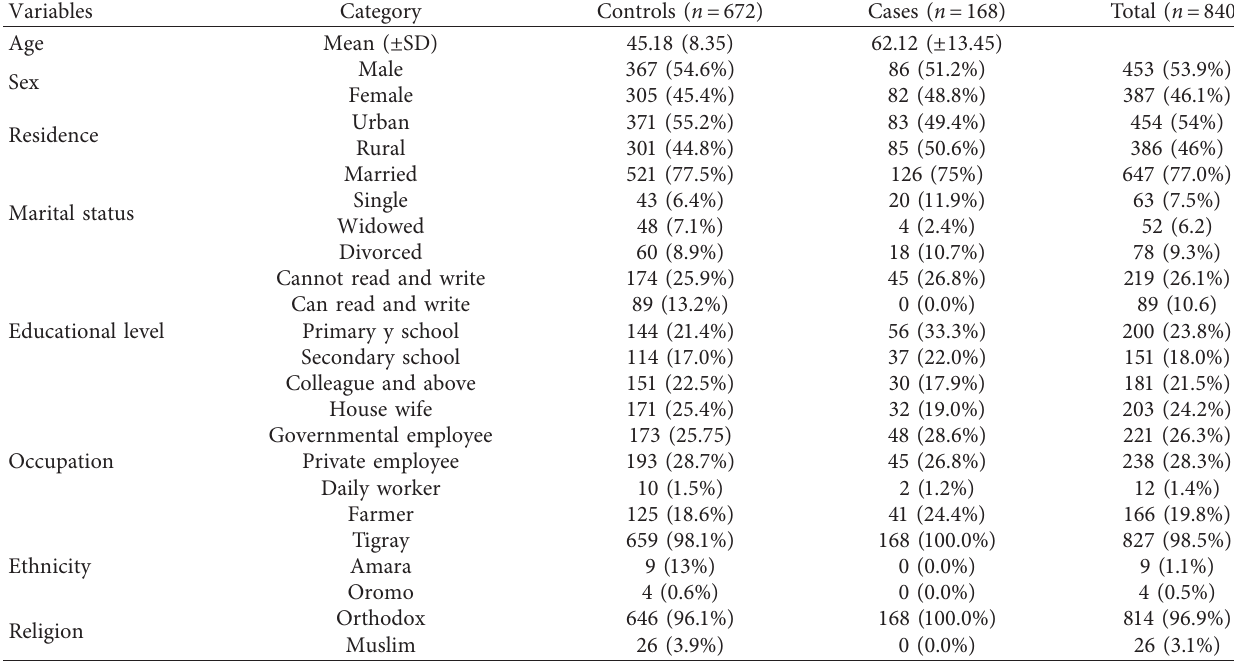
Table 1: Sociodemographic characteristics of the study participants on follow-up at public hospitals of Tigray, Ethiopia, 2019. Variables